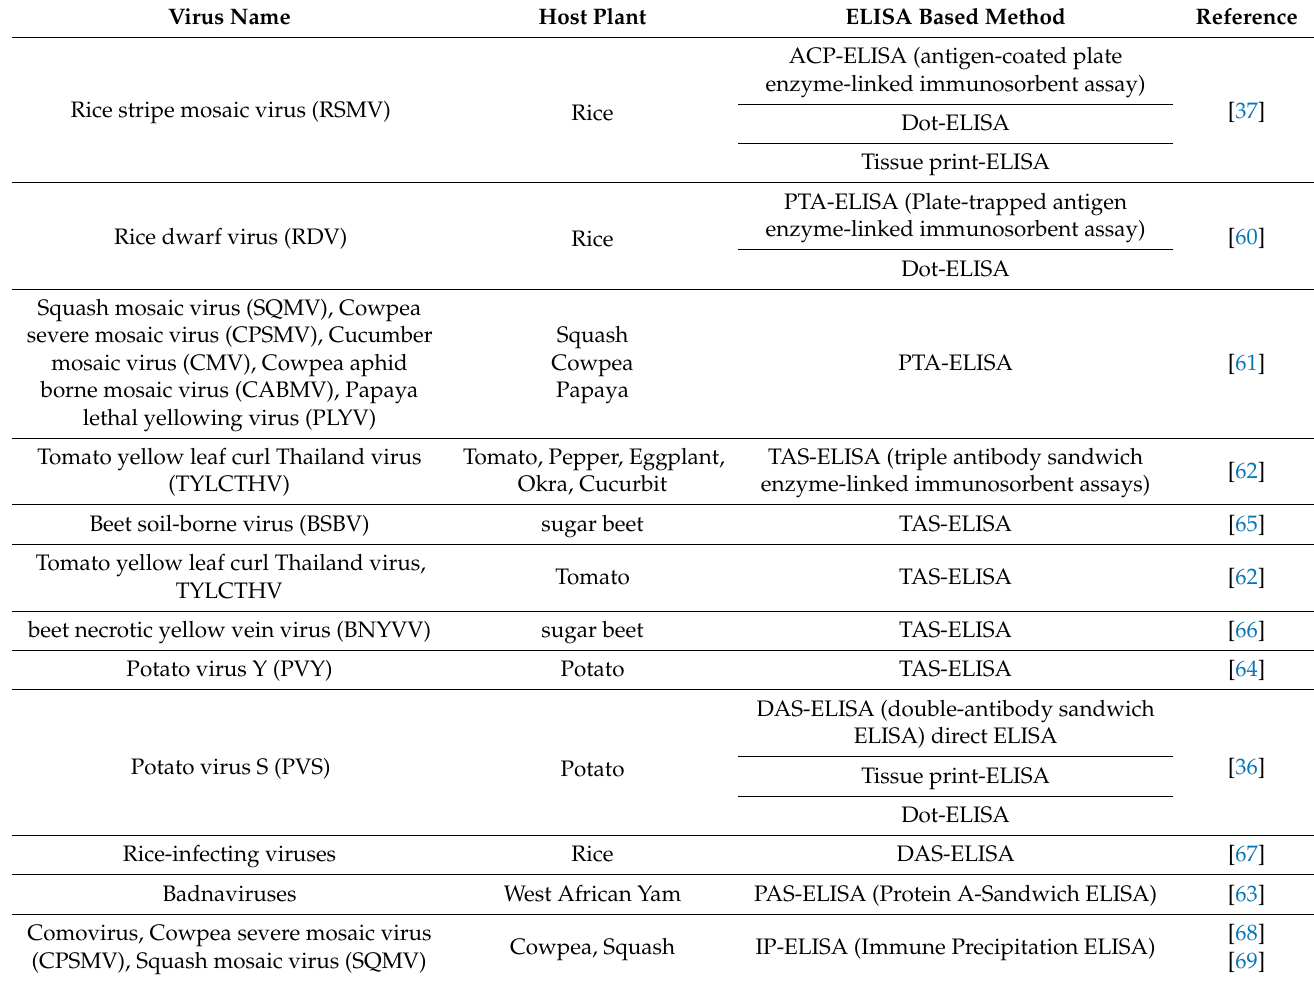
Table 1. Serological tests based on ELISA and its modified methods used employed in plant viral disease diagnosis for various important crops. Virus Name